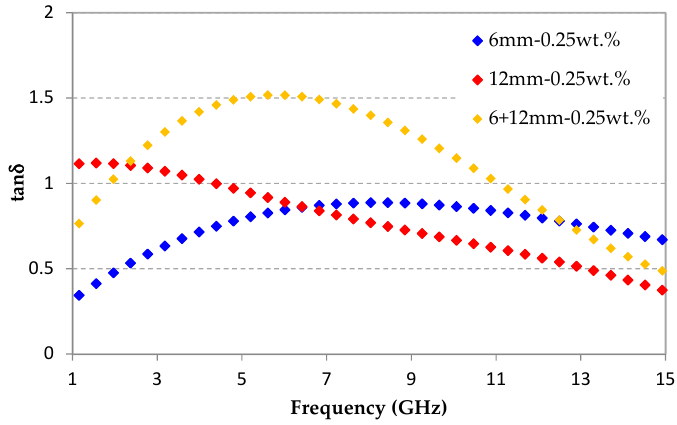
Figure 10. Dielectric losses of epoxy foams loaded with 0.25 wt.% of 6, 12, and 6 + 12 mm-CFs.